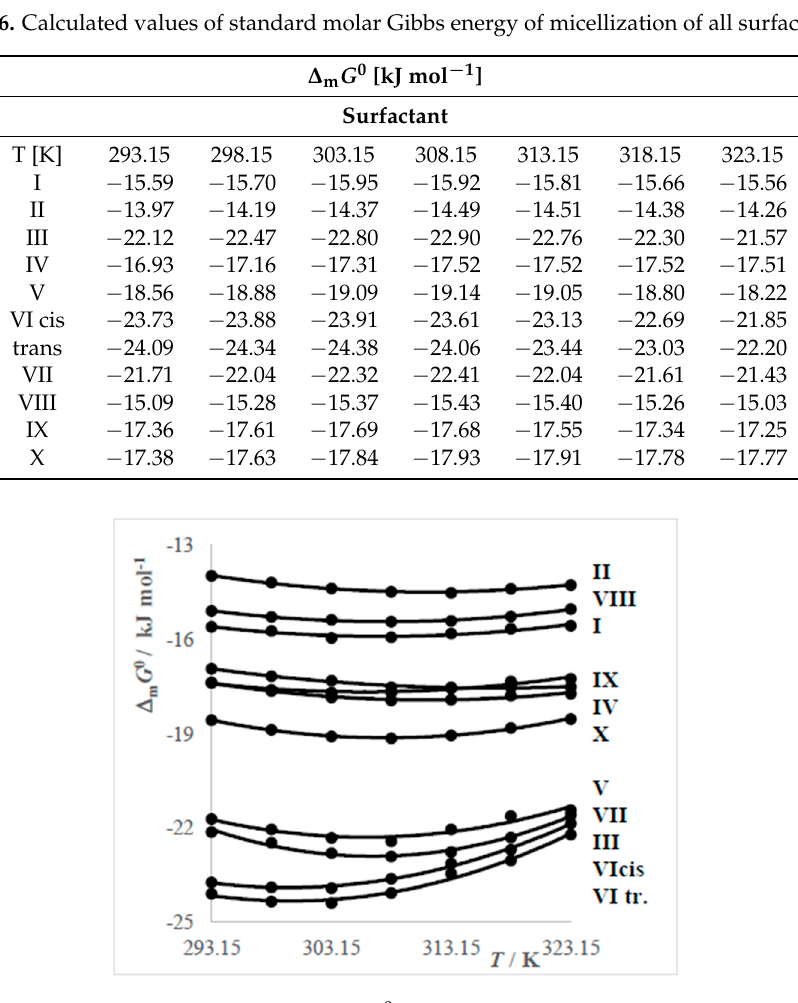
Table 6. Calculated values of standard molar Gibbs energy of micellization of all surfactants.